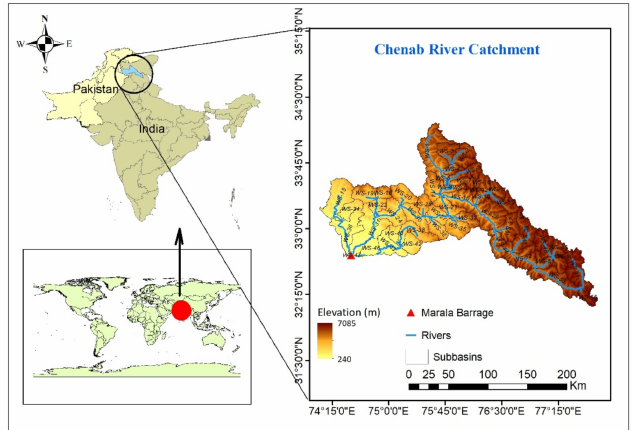
Figure 1. Topographic map of the Chenab River catchment representing river, 55 sub-basins and